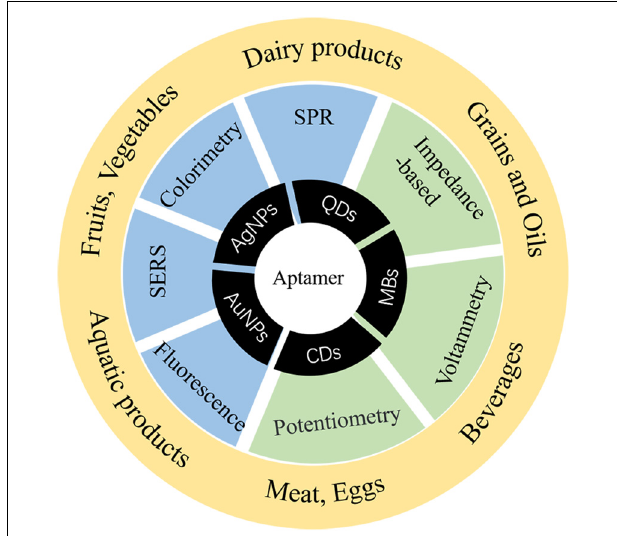
FIGURE 4 | Applicable materials, methods, and applications of aptamers for S. aureus risk